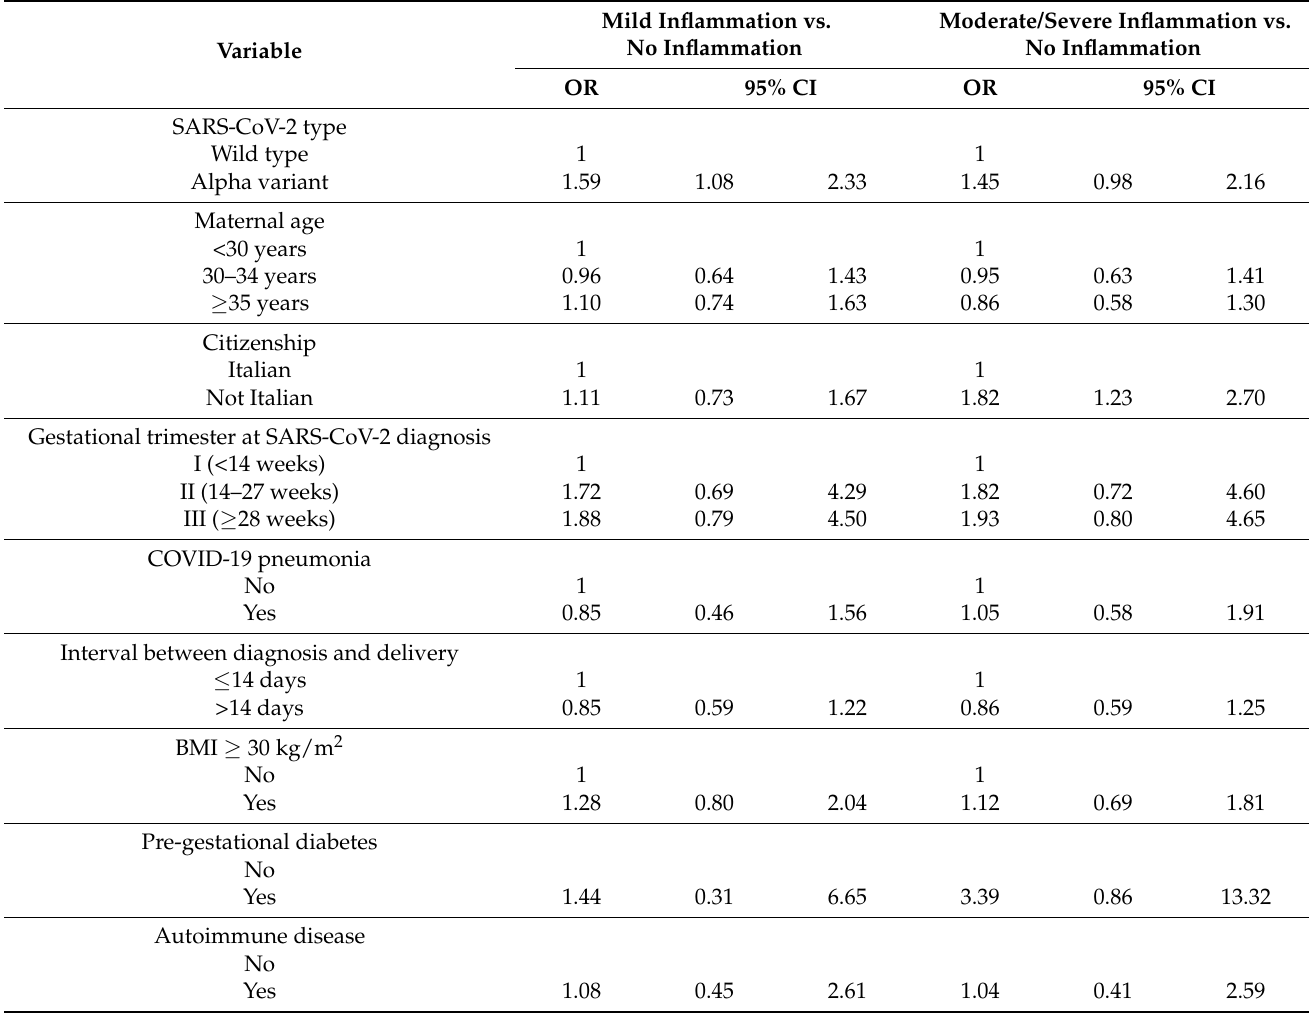
Table 2. Odds ratios of mild and moderate/severe placental disc inflammation— multinomial logistic regression model ( n = 932, four cases of preeclampsia